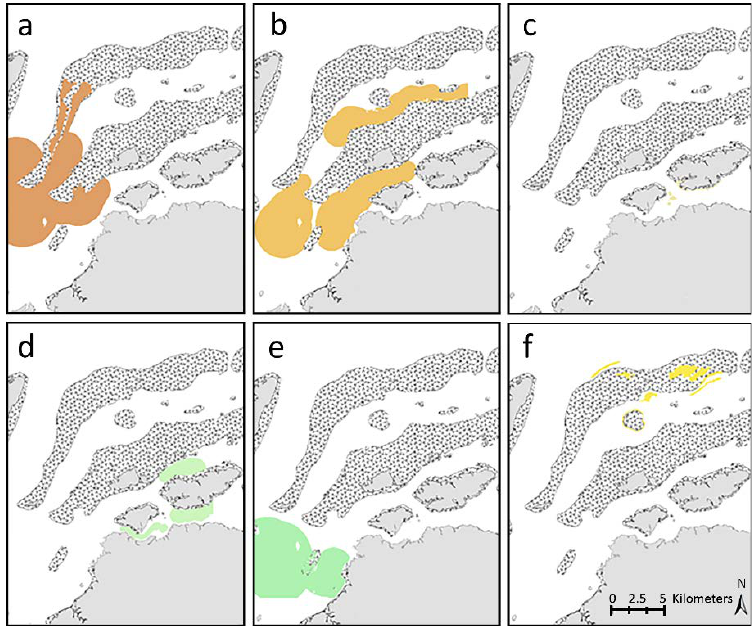
Figure 3. Example maps of reported fishing grounds used in 2010 by six individual fishers ( a – f ), collected through participatory mapping. Maps of individuals’ fishing grounds, such as the examples shown here, were combined to make maps of the maximum extent of fishing in a year at decadal intervals.